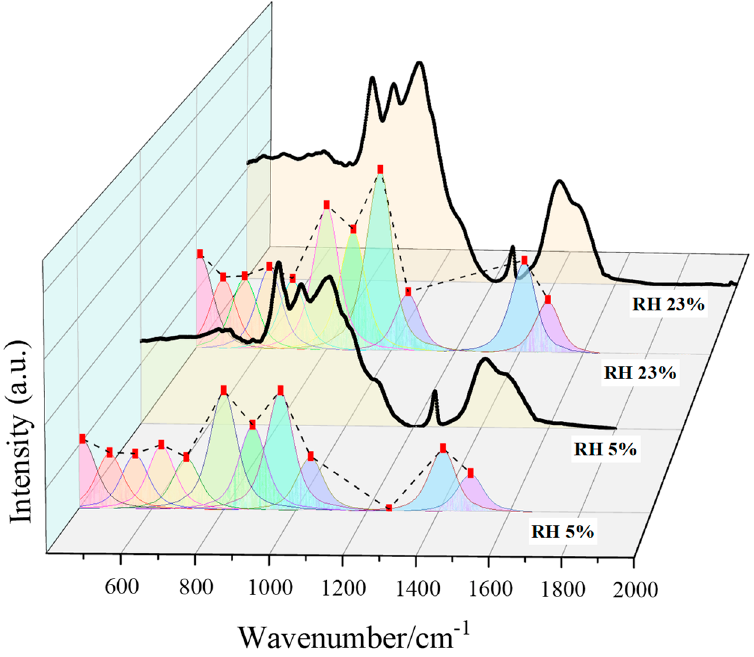
Figure 7. The fitting results of the FWHM of the samples cured at RH 5% and 23%. Table 7. The fitting results of the FWHM of all samples.